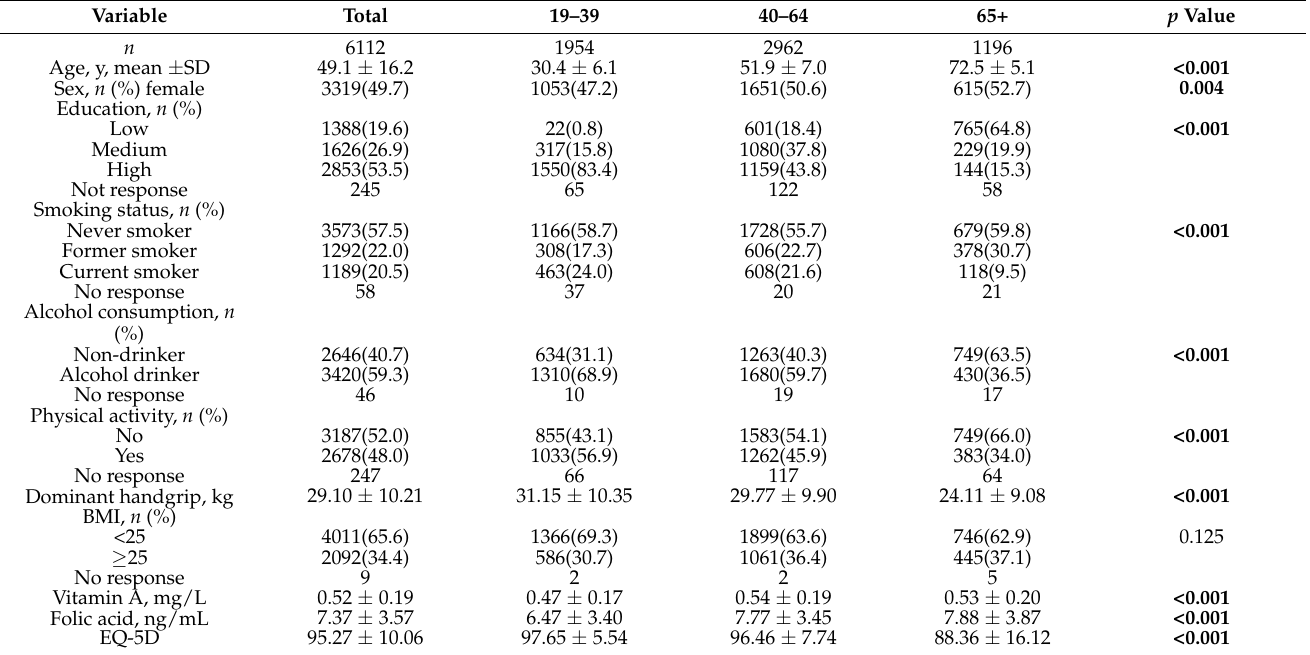
Table 1. Participants’ sociodemographic and clinical